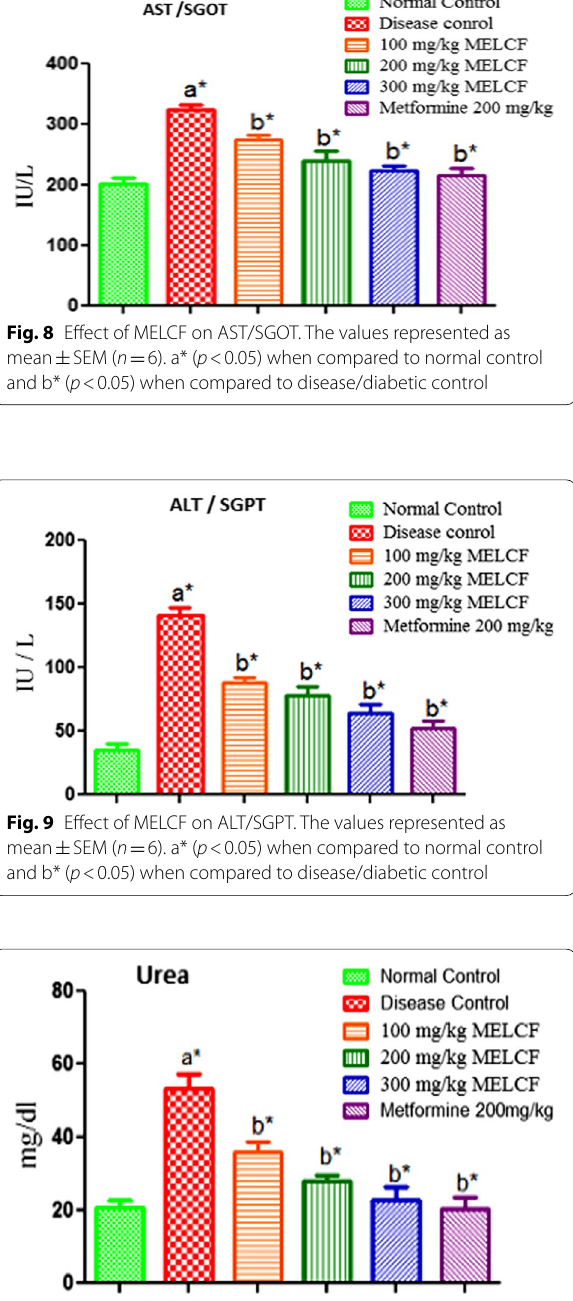
Fig. 10 Effect of MELCF on urea. The values represented as mean SEM ( n 6). a* ( p < 0.05) when compared to normal control ± = and b* ( p < 0.05) when compared to disaese/diabetic